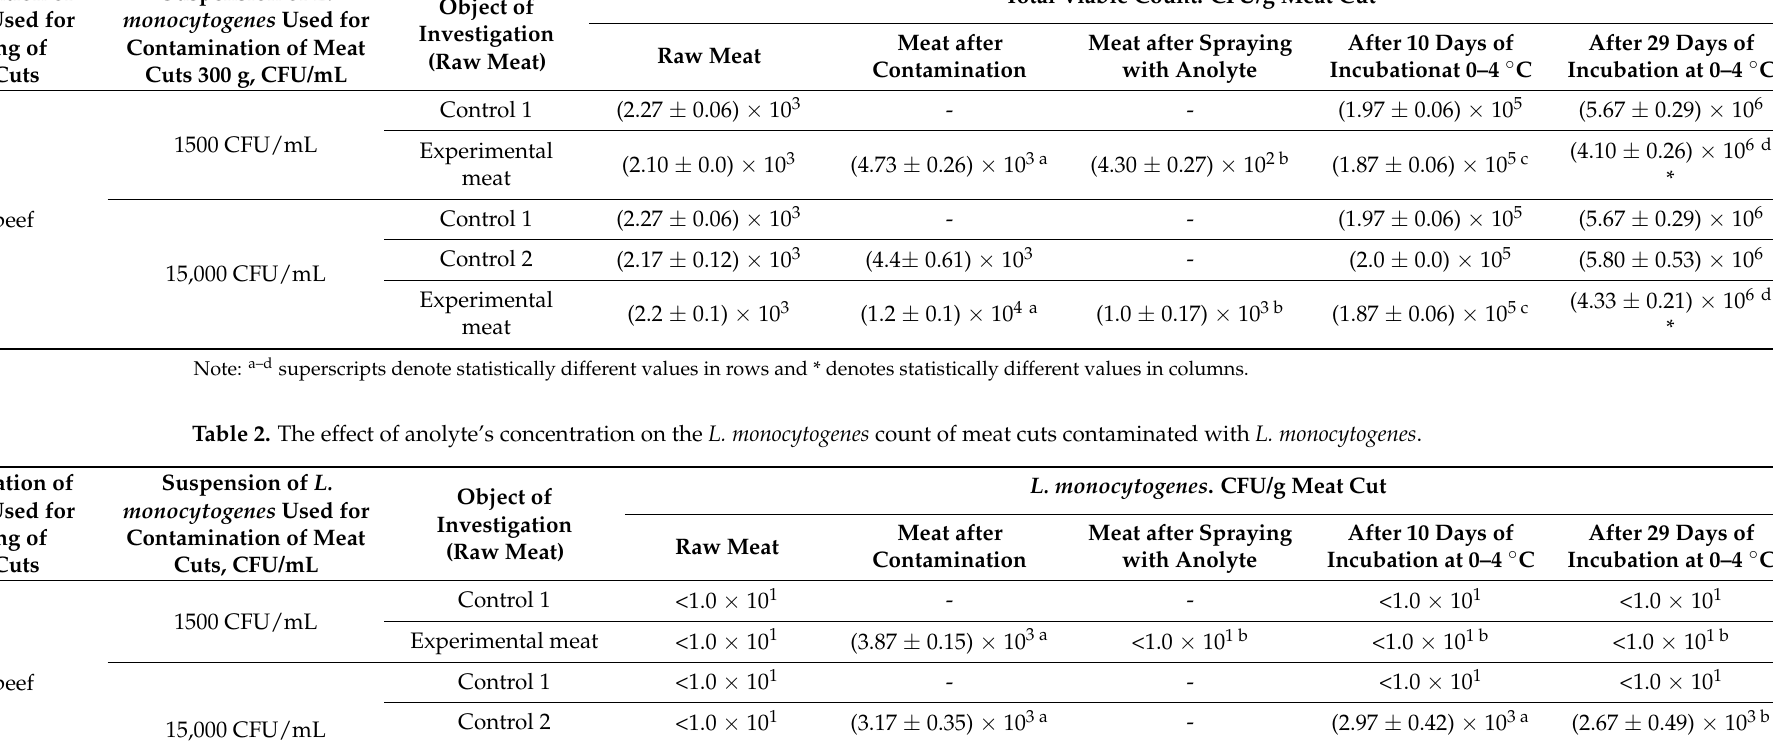
Table 1. The effect of anolyte’s concentration on the total viable count of meat cuts contaminated with L. monocytogenes . Concentration of Anolyte Used for Spraying of